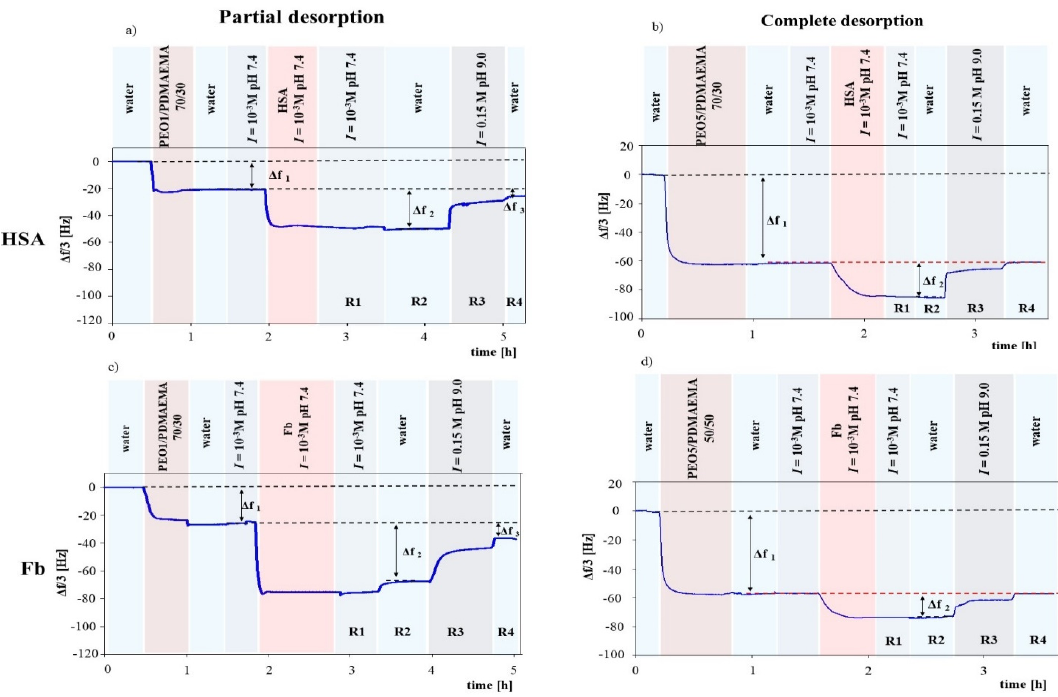
Figure 2. QCM graph of PEO/PDMAEMA mixed coatings formed on a gold surface followed by steps of adsorption/desorption of proteins: a ) HSA adsorption on PEO1/PDMAEMA 70/30, b ) HSA adsorption on PEO5/PDMAEMA 70/30 coatings, c ) Fb adsorption on PEO1/PDMAEMA 70/30, d ) Fb